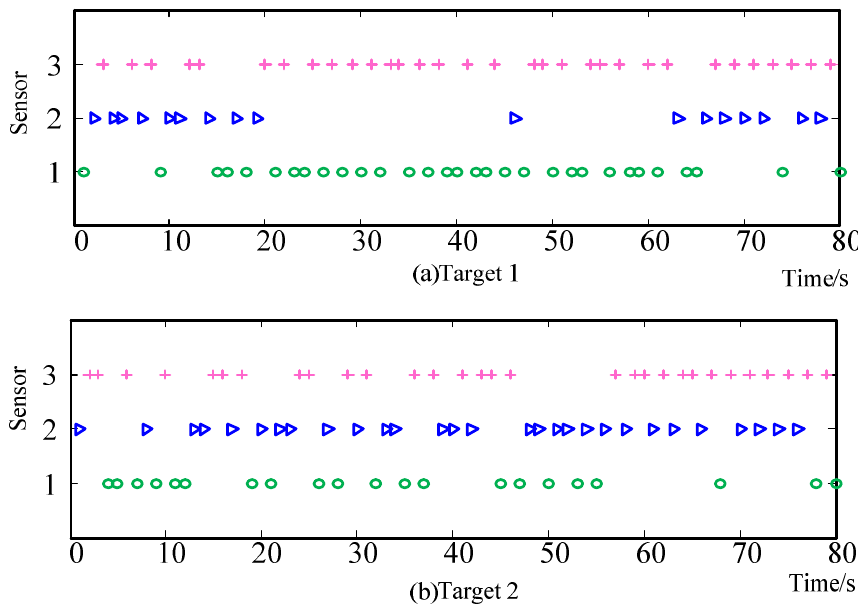
Figure 10. Sensor selected sequences obtained by IPFSP. ( a ) Target 1; ( b ) Target 2.